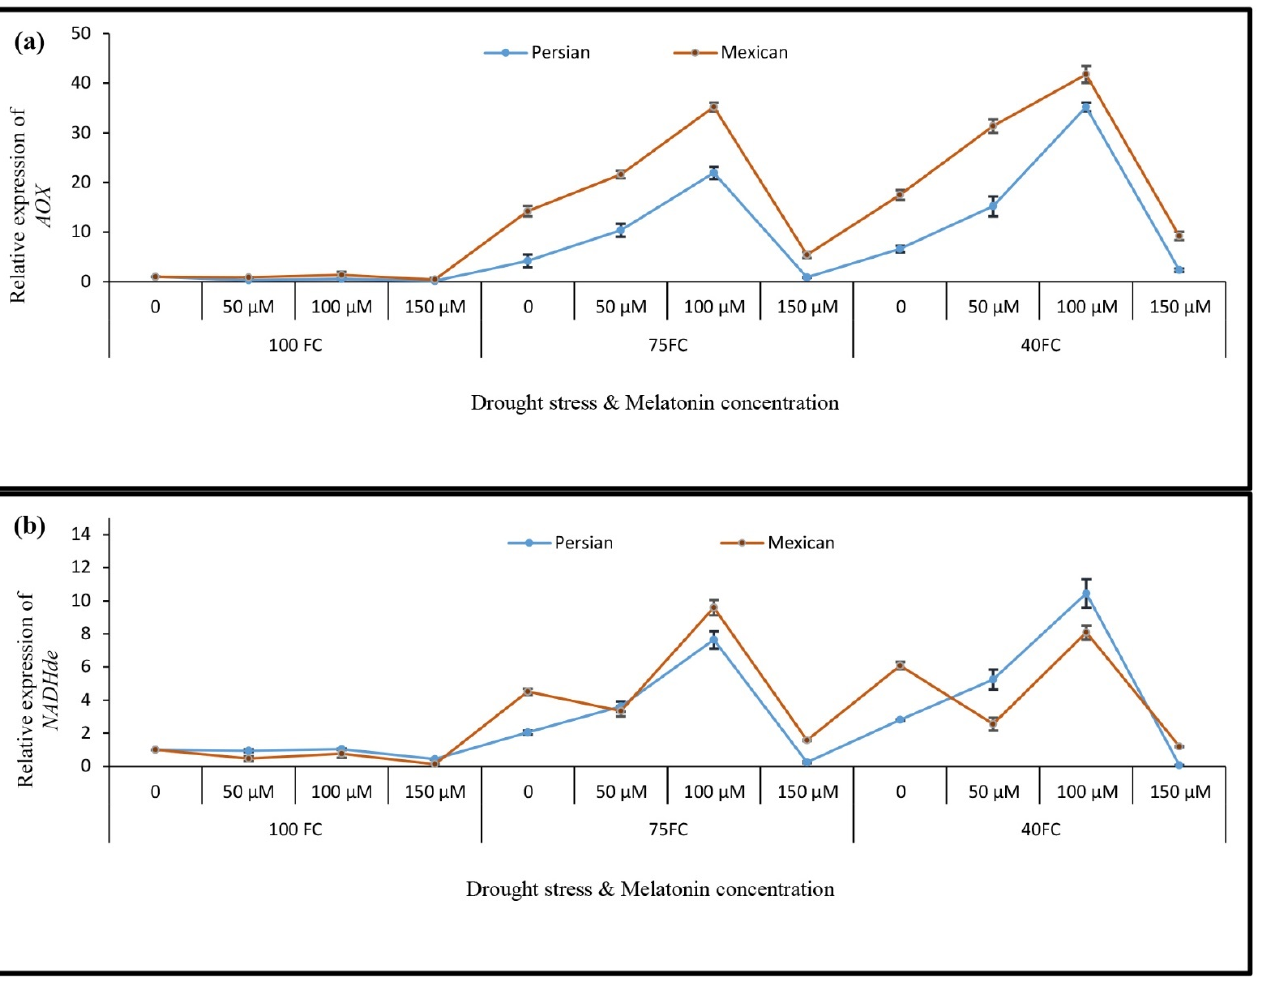
Figure 5. The effect of different concentrations of exogenous melatonin, Citrus species, and various levels of drought stress on the expression of cellular redox regulation genes including ( a ) alternative oxidase, AOX and ( b ) NADH dehydrogenase, NADHde . Data describe the means of three biological replicates with three technical replicates each. Error bars represent standard deviation (SD).